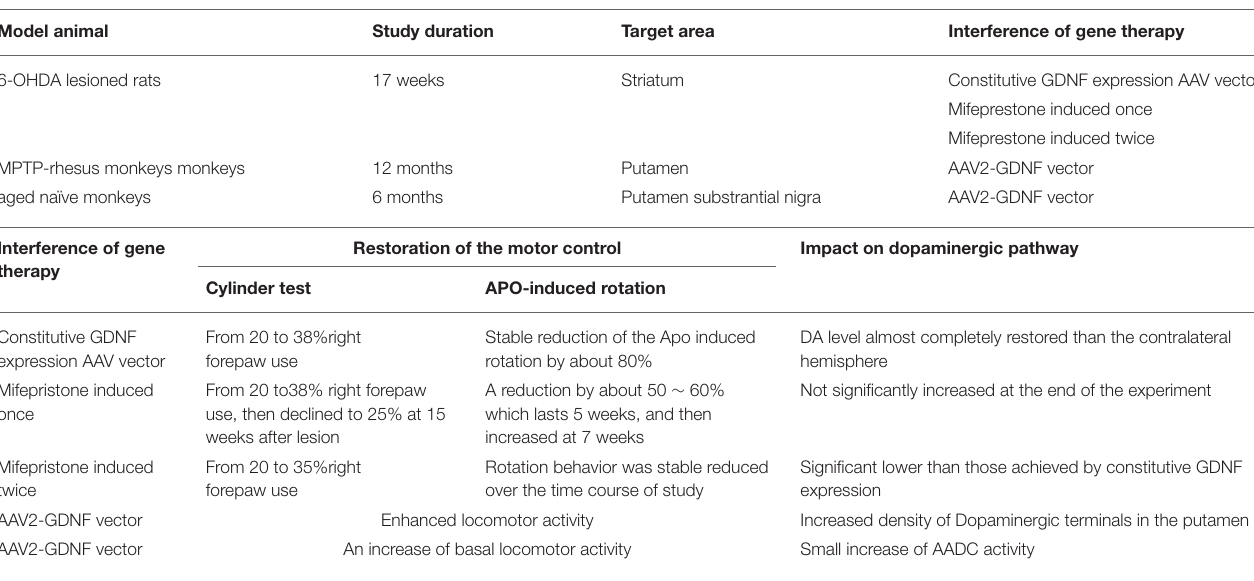
TABLE 2A | Gene therapy of